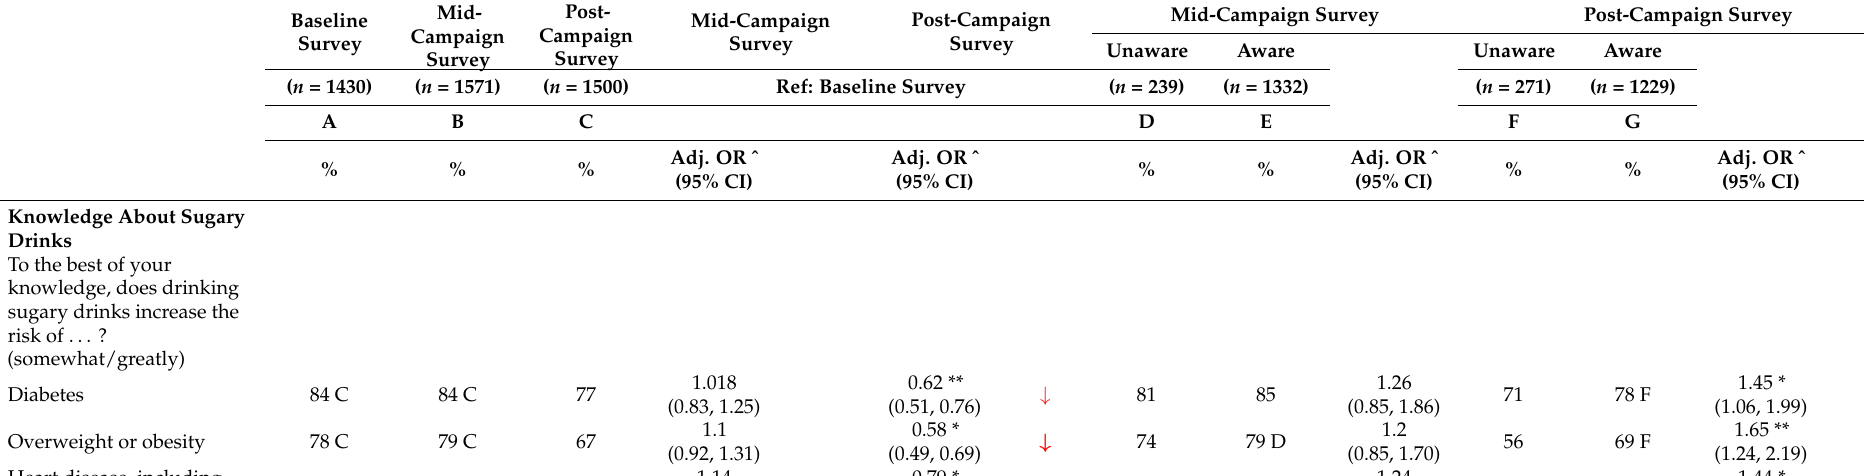
Table 5. Knowledge and attitude towards obesity and sugary drinks among respondents in the pre-campaign and post-campaign periods including a comparison of post-campaign respondents who were aware and unaware of the campaign. Post- Mid- Mid-Campaign Survey Post-Campaign Survey Post-Campaign Mid-Campaign Baseline Campaign Campaign Survey Survey Survey Unaware Aware Unaware Aware Survey Survey ( n = 1430) Ref: Baseline